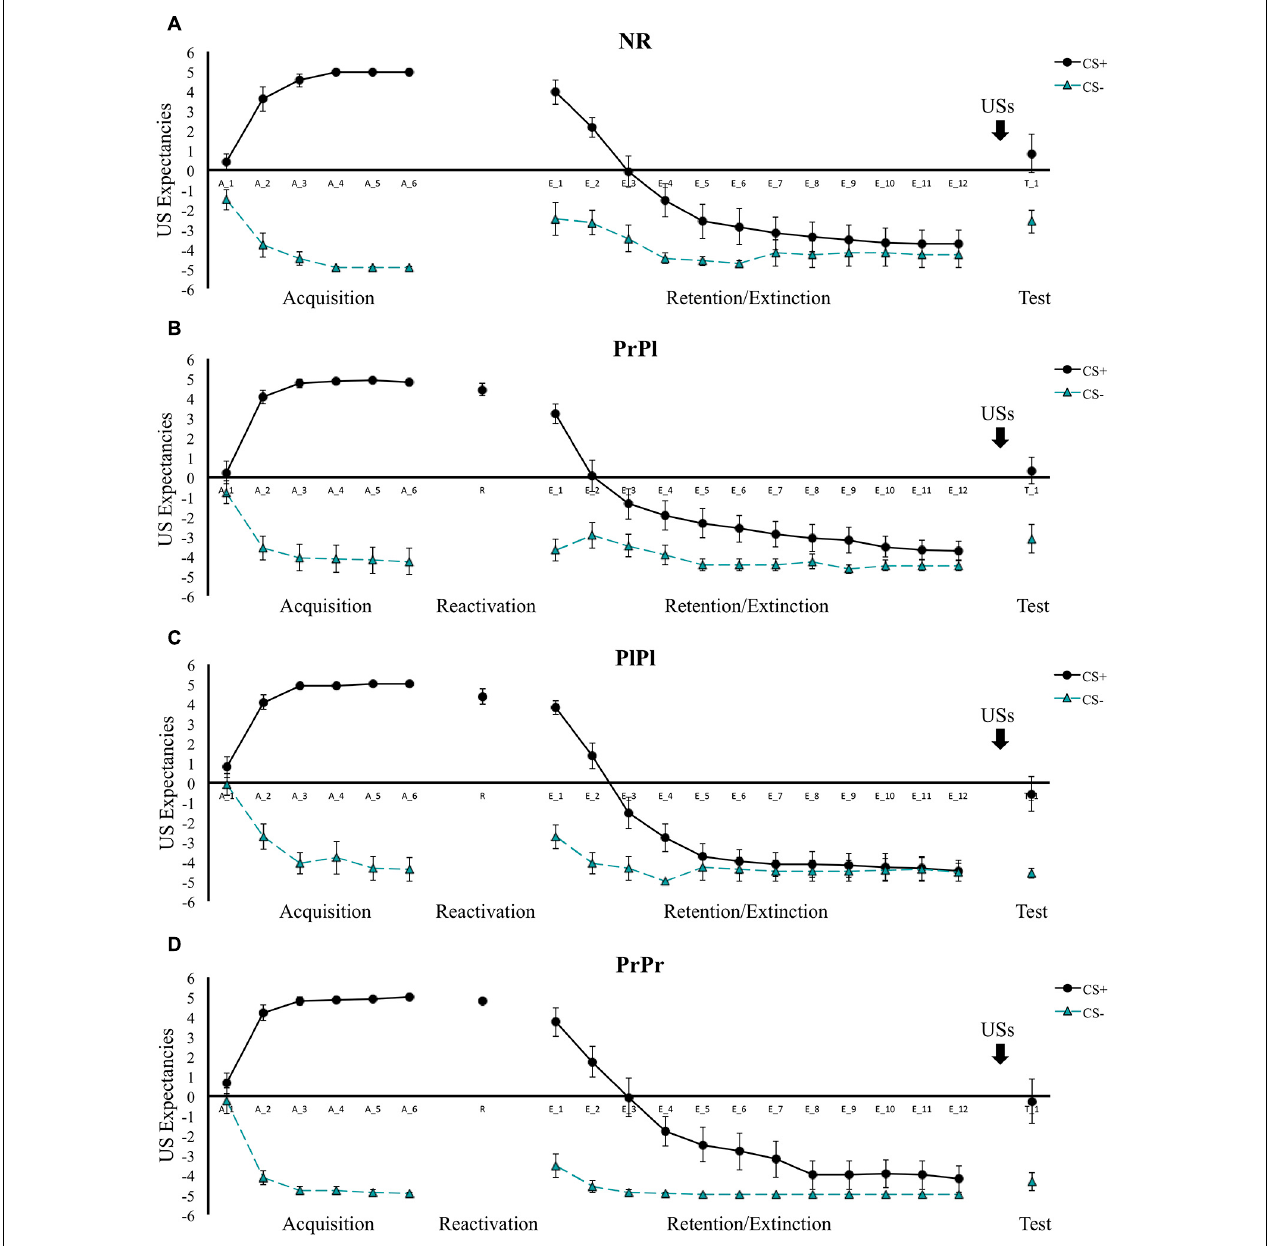
FIGURE 2 | Mean US expectancies across all phases for (A) the NR group, (B) the PrPl group, (C) the PlPl group, and (D) the PrPr group. Error bars represent standard error of the